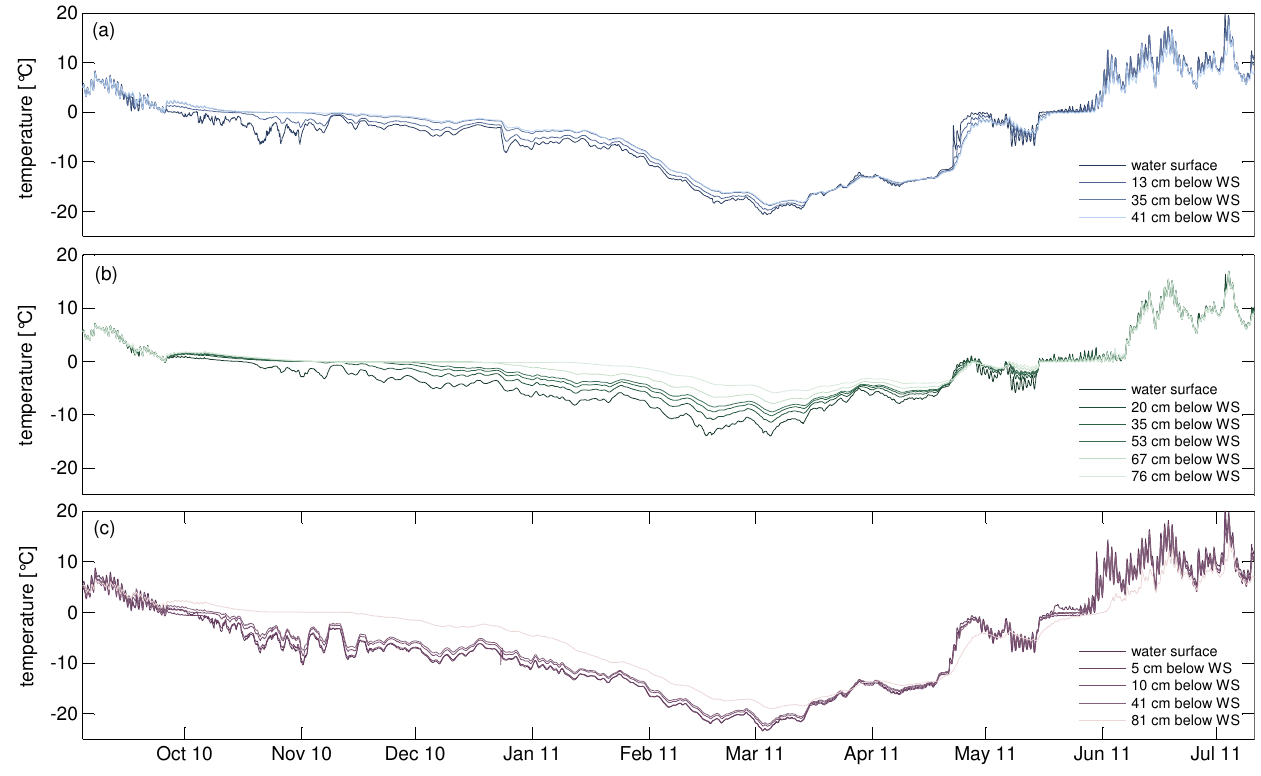
Fig. 13. Temperature dynamics in three polygonal ponds for 2010–2011: (a) Pond 1, (b) Pond 2, and (c) Pond 3.